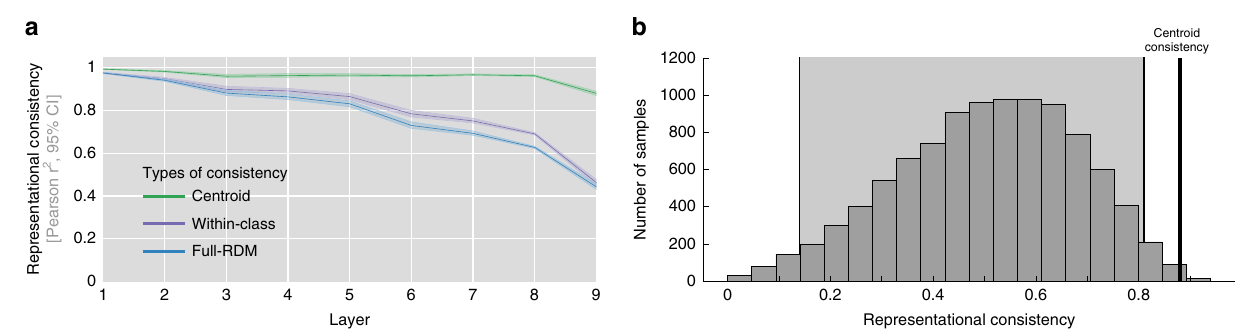
Fig. 7 Category centroids are highly consistent across network instances. a Centroid-based representational consistency (green) remains comparably high throughout, whereas the consistency of within-category distances decreases signi fi cantly with increasing network depth (error bars indicate 95% con fi dence intervals, average data shown, computed from 45 network comparisons across 10 network instances). This indicates that differences in the arrangement of individual category exemplars, rather than large-scale differences between class centroids are the main contributor to the observed individual differences. b High centroid-based representational consistency cannot be explained by the smaller RDMs or the averaging of multiple response patterns, as centroids of randomly sampled classes show a signi fi cantly lower mean consistency (95% CI in the light gray